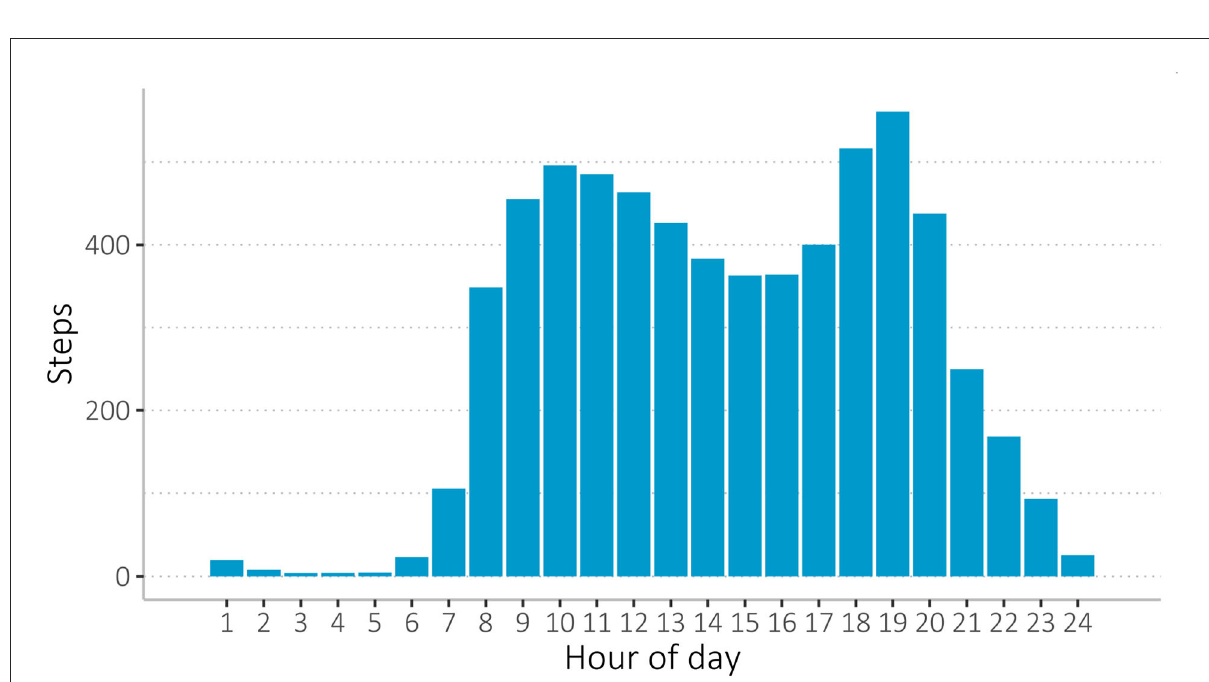
FIGURE8 Overview of average steps taken during the day per study participant (average of all study participants over the full 9-week study period), measured with the WPHR wearable. During the hottest part of the day, there is a drop in activity between 12 pm and 6 pm.